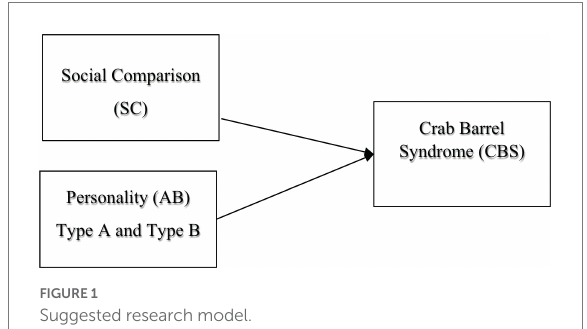
FIGURE 1 Suggested research